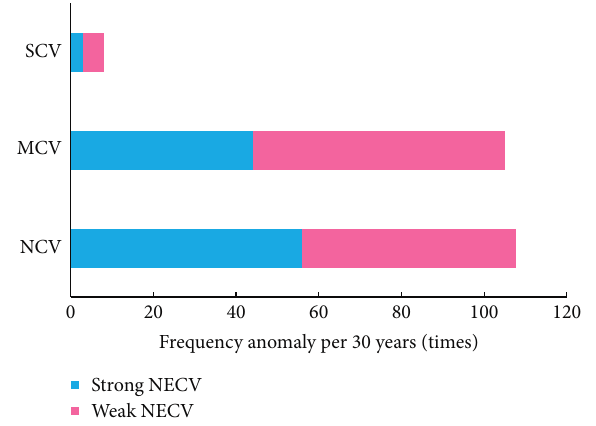
Figure 4: Occurrence frequency of strong and weak NECVs at different locations (unit: